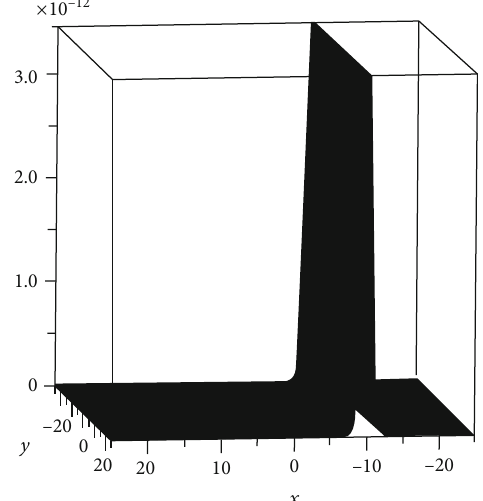
Figure 9: Graphical view of the absolute error for J ð ζ , ρ Þ of system 2